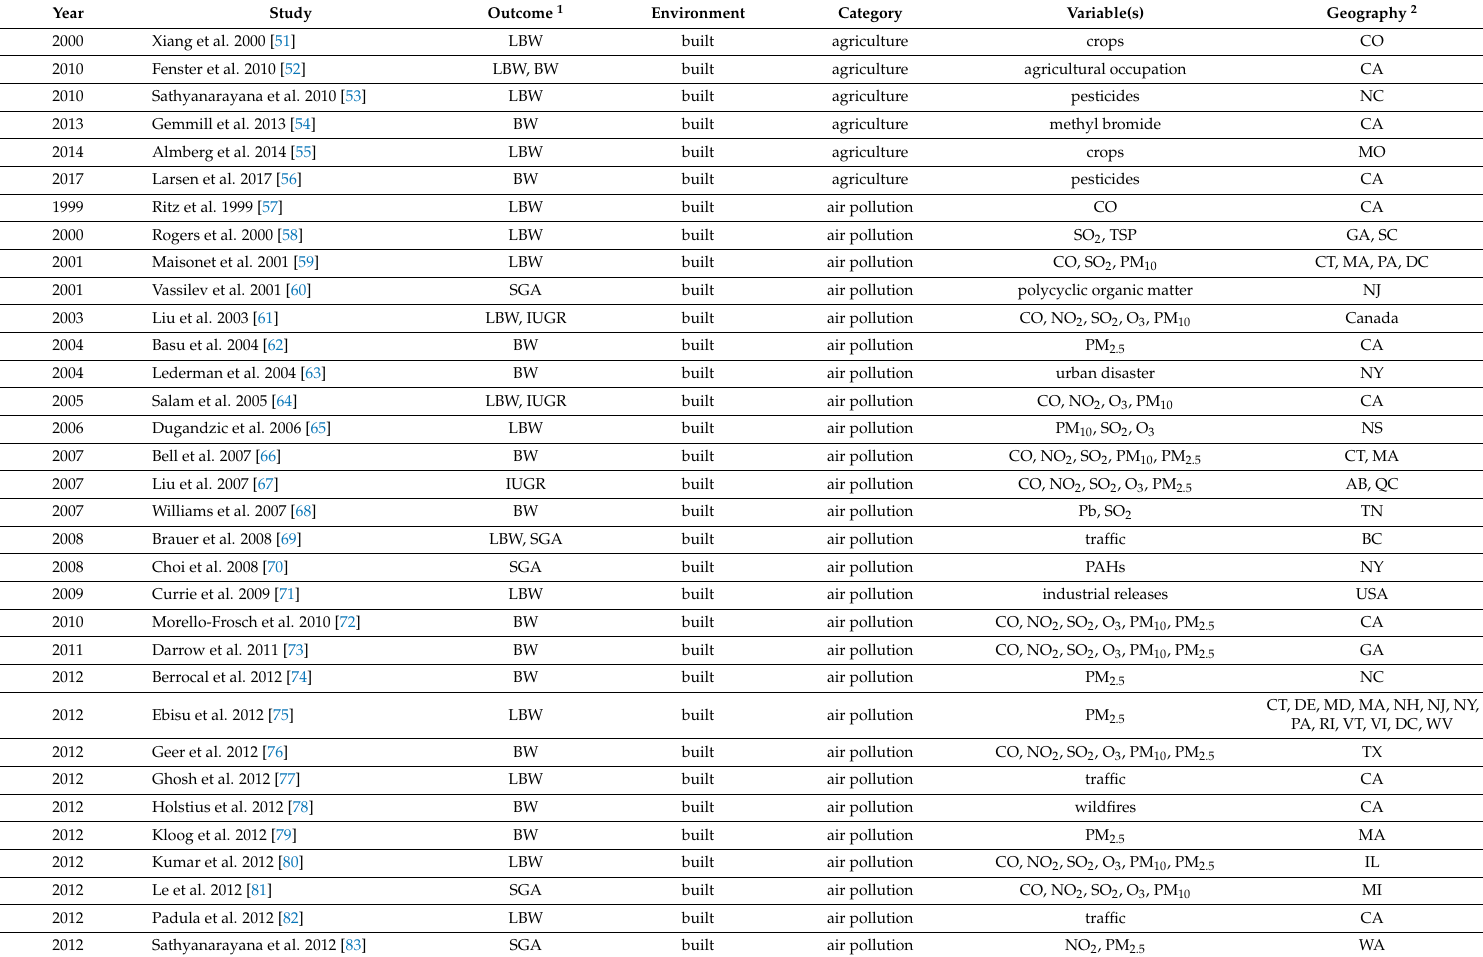
Table A2. List of 159 identified studies examining birth outcomes and the